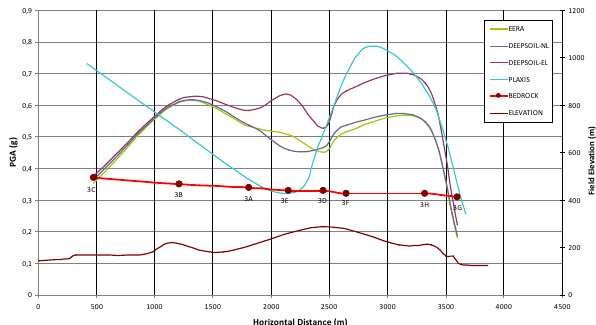
Figure 12. Change in the peak ground acceleration on the surface for the 3-3’ section